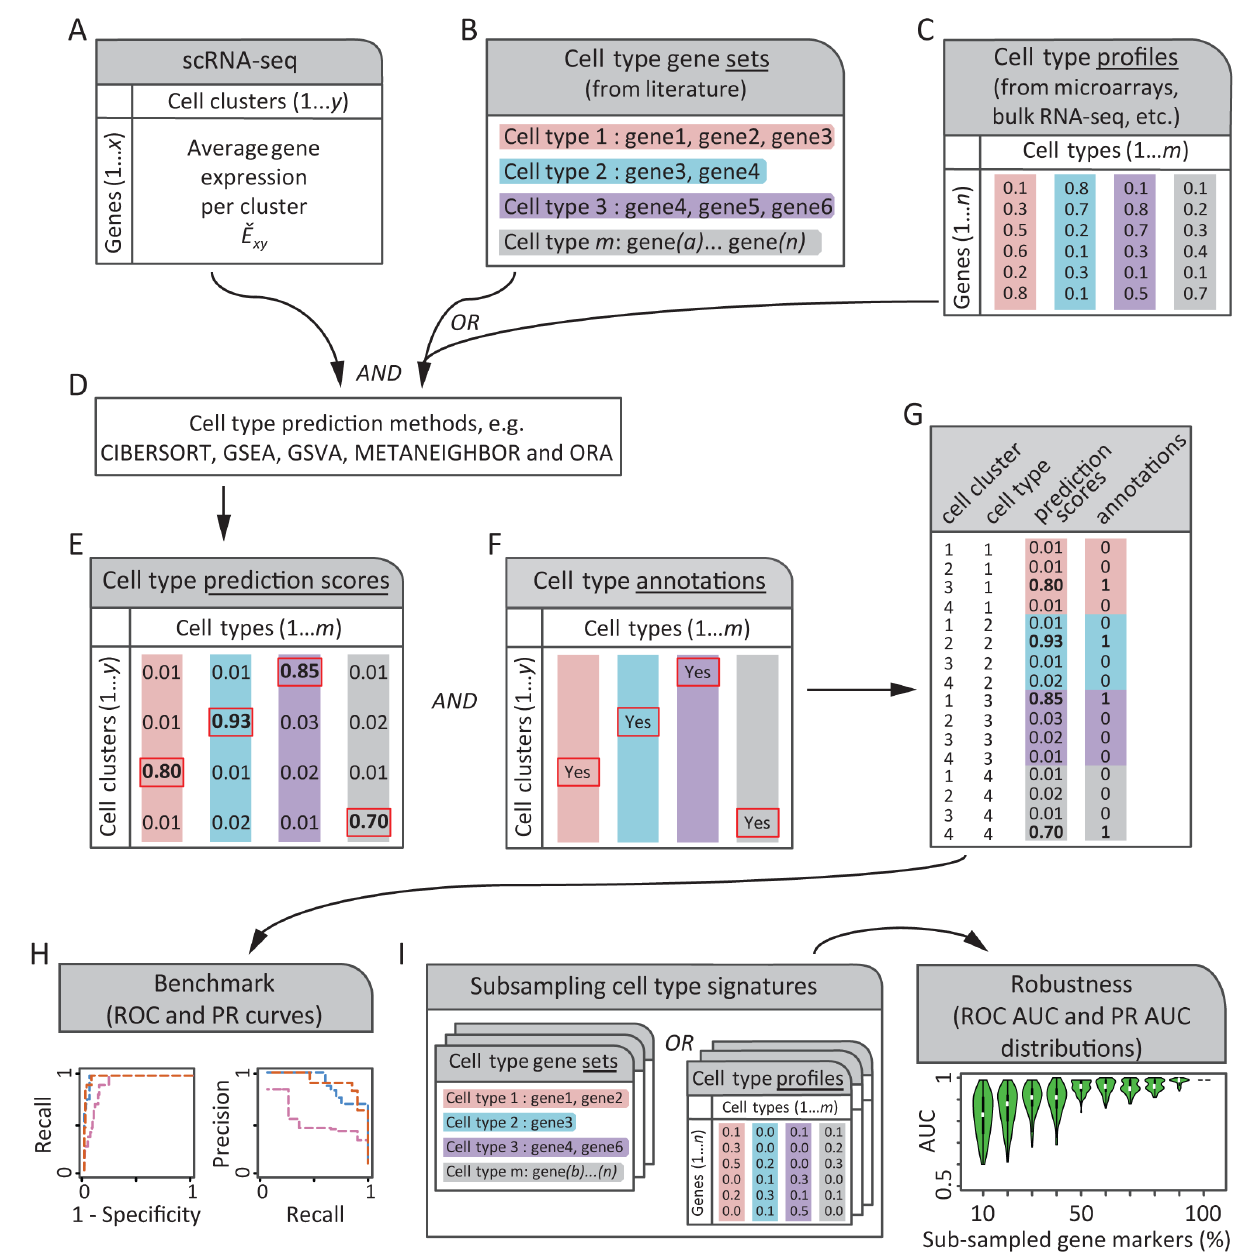
Figure 1. Schematic of a process to benchmark automated cell type prediction methods. Two inputs are needed by automated cell type prediction methods ( A – C ). ( A ) a matrix with the average expression of each gene x for each cell cluster y ( Ě ). ( B , C ) cell type gene xy marker signatures can be provided as either gene sets (lists of gene identifiers, B ) or numeric gene expression profiles ( C ). ( D ) Gene sets can be manually compiled from literature and are used for methods like GSEA, GSVA or ORA, whereas gene-expression profiles are measurements from microarrays, bulk- or single-cell RNA-sequencing (scRNA-seq) experiments and are used by methods like CIBERSORT and METANEIGHBOR. ( E ) Automated cell type prediction methods produce a matrix of cell type prediction scores for each cell cluster. ( F ) Some authors of scRNA-seq studies assign cell type labels manually to cell clusters using local expertise or orthogonal experiments such as fluorescence activated cell sorting. These annotations can be used as a gold standard to benchmark automated cell type predictions. ( G ) Cell type prediction scores (from E ) for cell clusters are concatenated into a single vector and known cell cluster annotations (from F ) are added. The resulting matrix is used to assess the performance of cell type prediction methods by receiver operating characteristic (ROC) curve and precision-recall (PR) curve analyses varying over the prediction scores for all cell clusters in a dataset ( H ). ( I ) Robustness of cell type prediction methods can be analysed by gradually subsampling gene markers from cell type gene expression signatures ( B or C ) and repeating procedures of ( D – H ) to obtain distributions of the area under the curve (AUC) for ROC (ROC AUC) and PR (PR AUC) curves, which are shown as violin plots. We hypothesized that some prediction methods are more robust than others to the proportion of gene markers subsampled from cell type gene expression